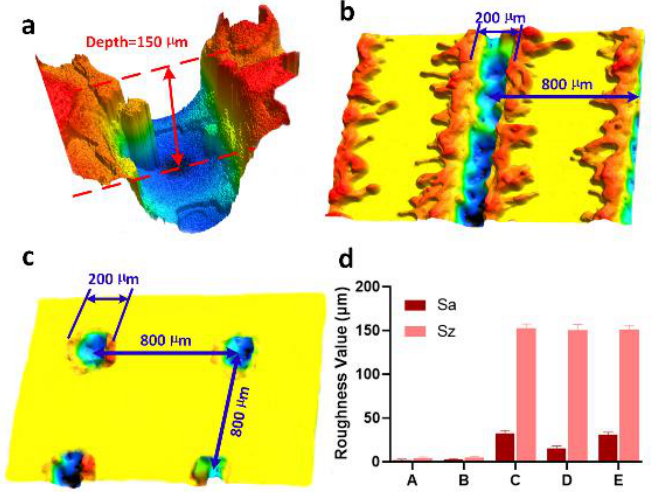
Figure 3. Surface morphology and roughness of different samples: ( a ) 3-D profile of a hole created by single laser pulse; ( b ) 3-D surface profile of sample C; ( c ) 3-D surface profile of sample D; ( d ) S a and S z measurement results of for samples A–E.